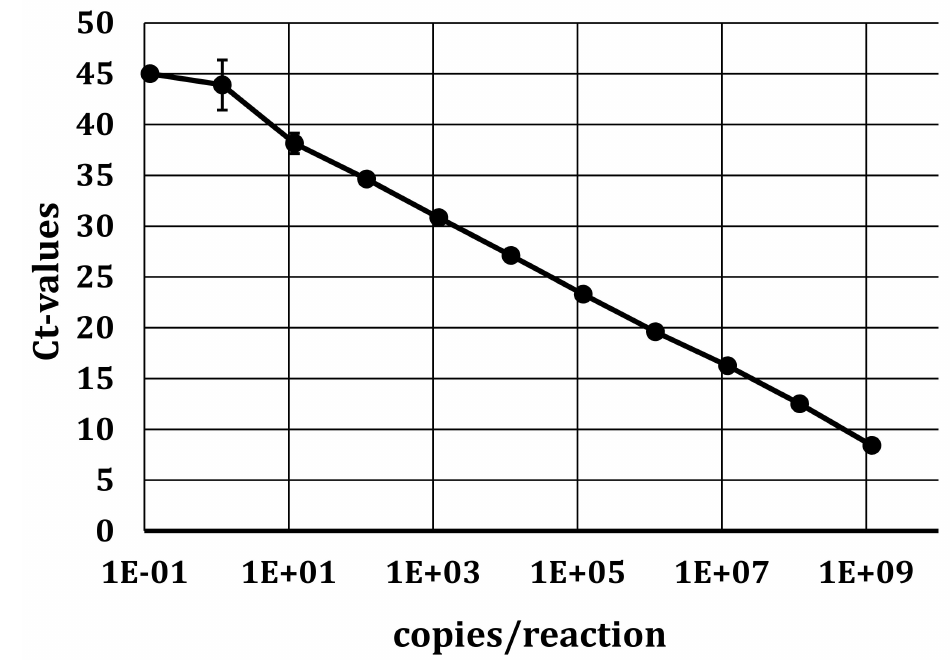
Figure 1. qRT-PCR standard curve of in vitro transcribed APPV RNA in the 5 (cid:48) UTR. A tenfold dilution series within a range of 1 × 10 9 molecules / reaction to 1 × 10 − 1 molecules / reaction was performed. Targeting the FAM reporter, an e ffi ciency of 86.5% was achieved. The slope of the standard curve was − 3.7 with a standard deviation (SD) between 1 and